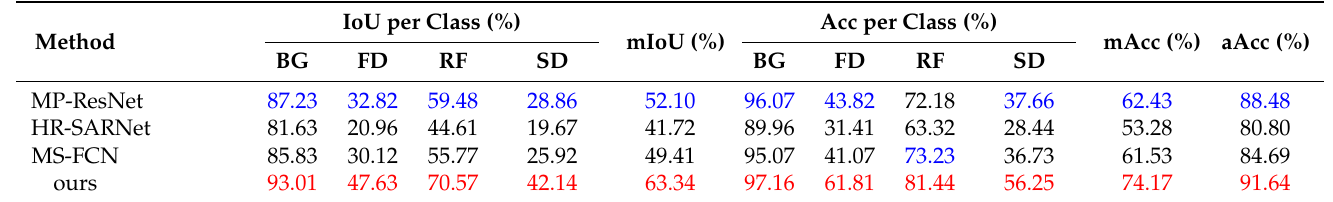
Table 3. Comparison of the results of our method and other methods designed for SAR image on the SARMV3D